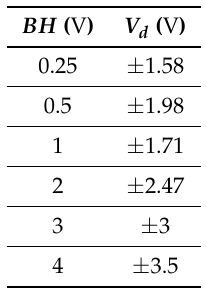
Table 2. Hysteresis band values obtained in